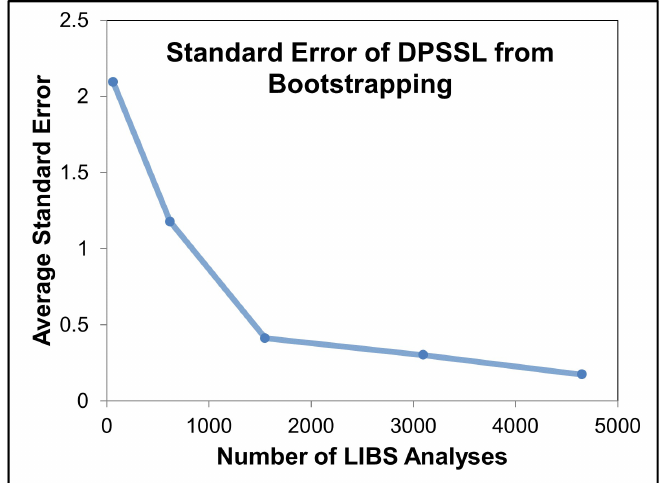
Figure 21. Comparison of the number of LIBS analysis spots used and the average range of grain size proxy values calculated for all 26 test samples. This trend shows that about 620 total 150 µ m LIBS analysis are required to rank samples in terms of Cu-sulfide mineral grain size proxies to a satisfactory